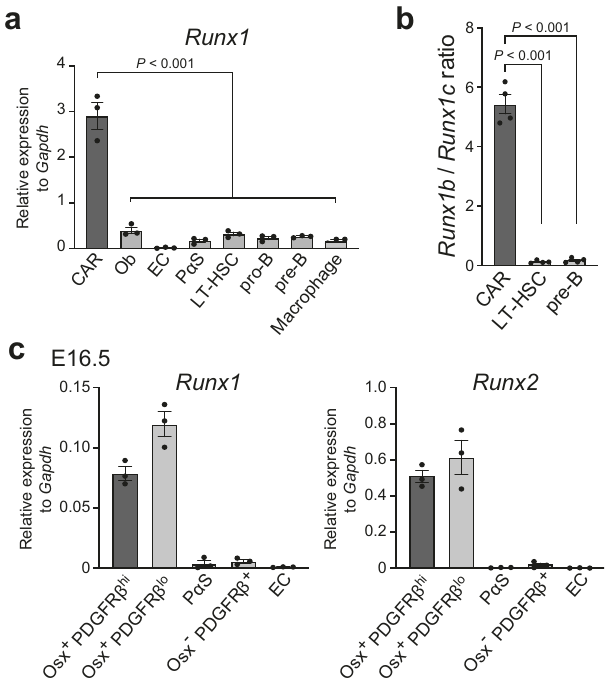
Fig. 1 Runx1 is predominantly expressed in CAR cells in adult bone marrow. a Relative mRNA expression levels of Runx1 in CAR cells, osteoblasts (Ob), endothelial cells (EC), P α S cells, LT-HSCs, pro-B cells, pre-B cells, and F4/80 + macrophages in the bone marrow of 15-week-old CXCL12-GFP mice ( n = 3 mice per group). b The ratio of Runx1b mRNA levels to Runx1c mRNA levels in CAR cells, LT-HSCs, and pre-B cells ( n = 4 mice per group). c Relative mRNA expression levels of Runx1 and Runx2 in Osx-GFP + PDGFR β hi CAR cell progenitors, Osx-GFP + PDGFR- β lo osteoblast progenitors, P α S cells, Osx-GFP - PDGFR β + non-endothelial cells, and EC in E16.5 Osx-GFP mice ( n = 3 mice per group). All error bars represent SD of the mean. Statistical signi fi cances were calculated using one-way ANOVA with Dunnett ’ s test ( a , b ). Source data are provided as a Source Data fi